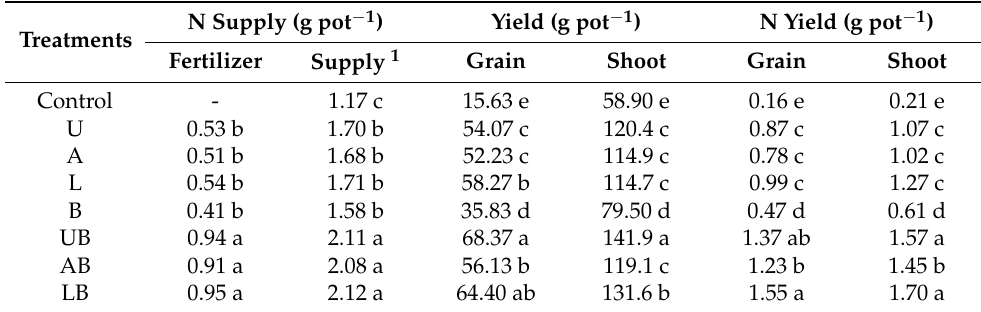
Table 3. Nitrogen supply, yields and nitrogen yields as affected by treatments and N supply.